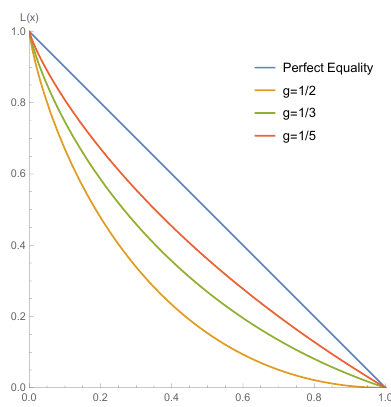
Figure 5: Examples of shifted exponential generators for different values of g .